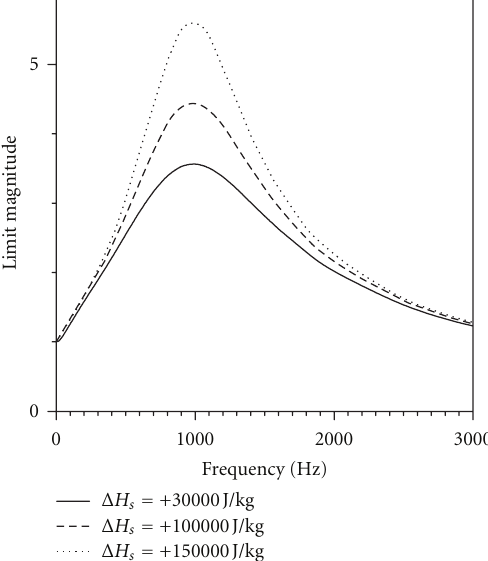
Figure 2: Frequency response of reference propellant ( r b , o = 1 . 27 cm/s, K b = 20000 s − 1 , di ff ering Δ H s ) in terms of nondimen- sional limit